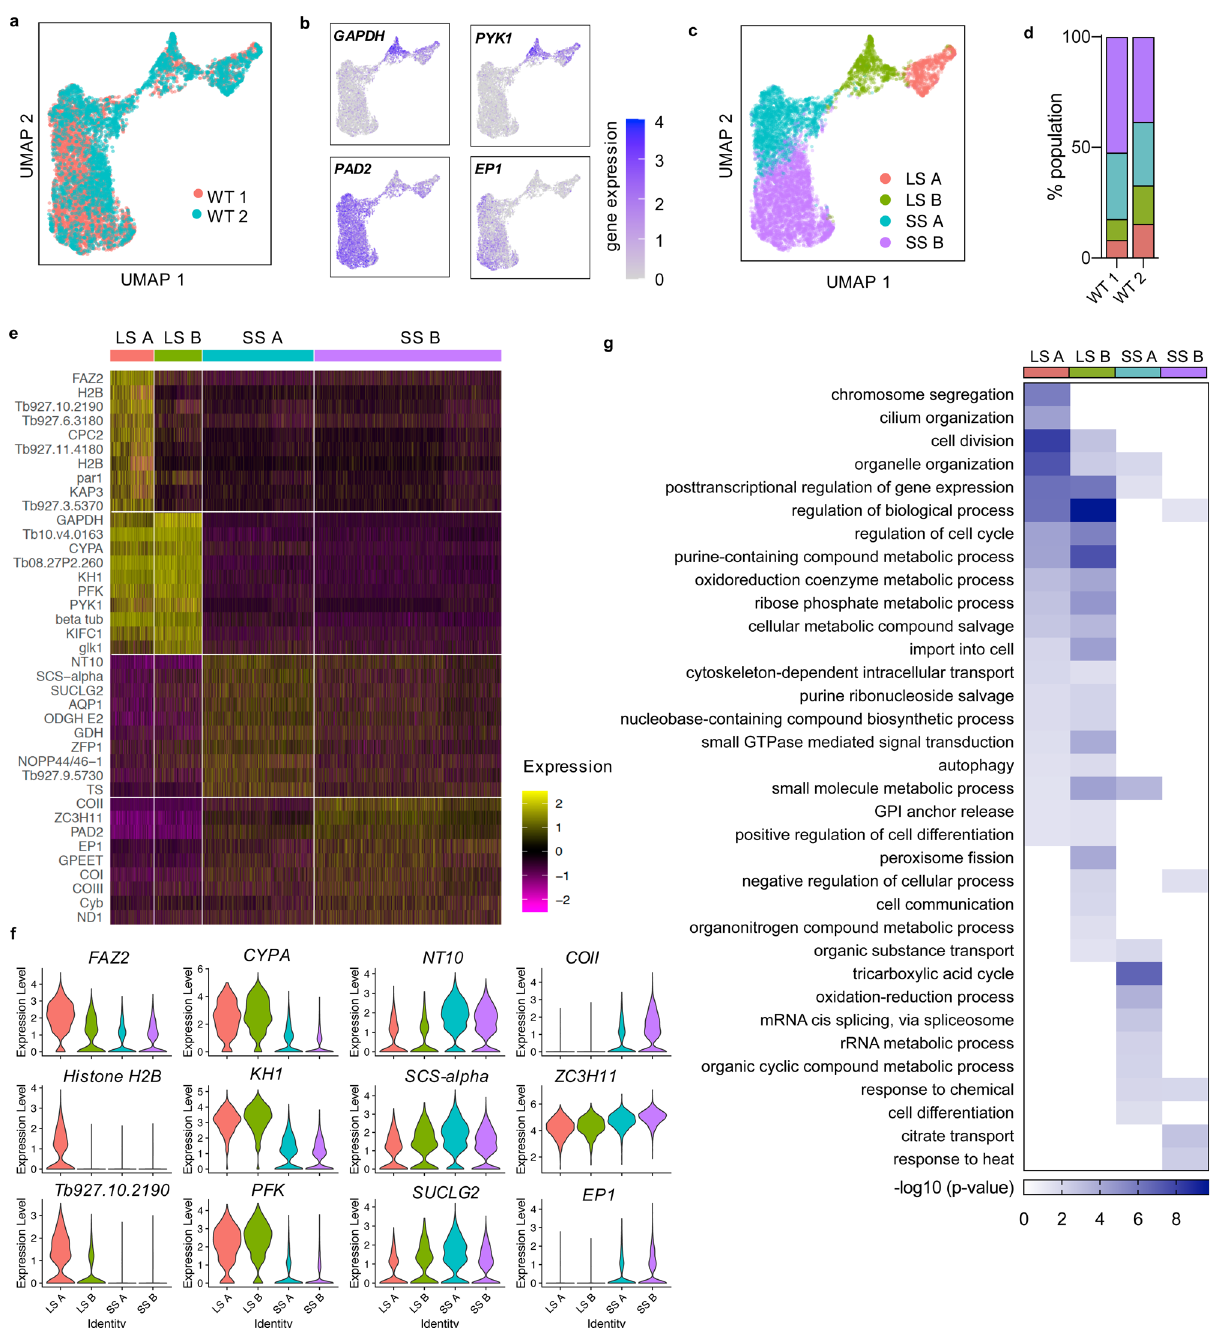
Fig. 1 Sequencing of individual T. brucei transcriptomes during bloodstream differentiation in vitro. a Low dimensional plot (UMAP) of each cell after fi ltering. Each point is the transcriptome of one cell positioned according to similarity with neighbouring transcriptomes, coloured by replicate experiment (WT 1 in red and WT 2 in blue). b UMAP of integrated WT parasite transcriptomes coloured by transcript counts for two slender marker genes ( GAPDH ; Tb927.6.4280 and PYK1 ; Tb927.10.14140) and two stumpy marker genes ( PAD2 ; Tb927.7.5940 and EP1 ; Tb927.10.10260). Scale shows raw transcript count per cell. c UMAP of WT parasites from both replicates, coloured by cluster: Long slender (LS) A (red), LS B (green), short stumpy (SS) A (blue) and SS B (purple). d Percentage of parasites in each cluster for each replicate experiment. Colours as in ( c ). e Heatmap showing relative expression levels (log2 normalised z-score) of the top 10 maker genes of each cluster identi fi ed in ( c ). Each row is one gene coloured by relative expression. Where no gene name or symbol was available, the gene ID is shown. Each column is one cell grouped according to cluster. f Violin plots showing the expression of each of the top 3 marker genes per cell, divided by cluster. Y-axis shows the raw transcript count per cell. g Gene ontology (GO) enrichment for biological processes linked with maker genes for each cluster. Scale shows the − log10( p -value), calculated with two-tailed Fisher ’ s exact test, for each term enrichmened per